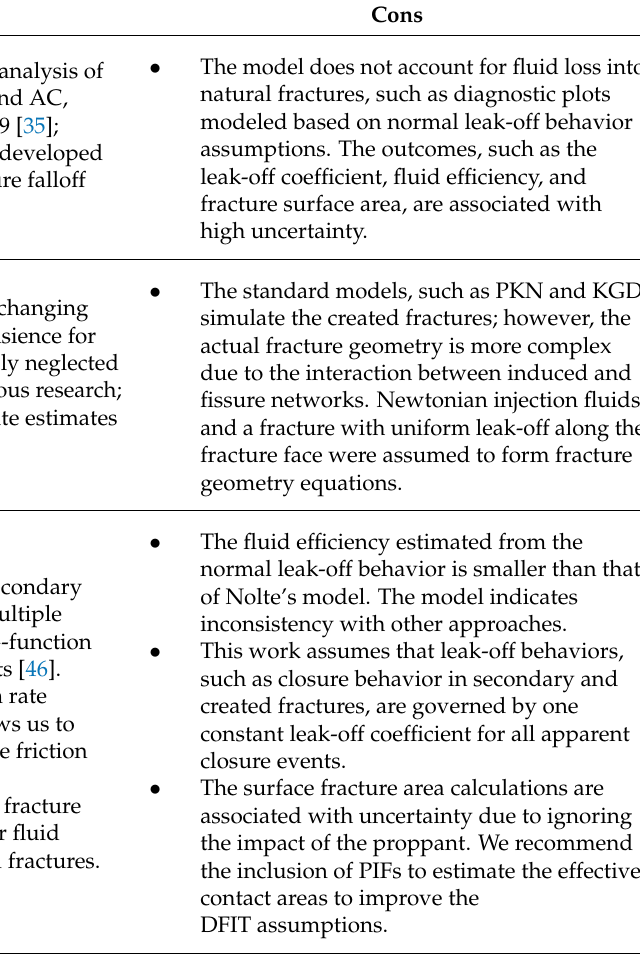
Table 7. Recently published DFIT models under the conditions of abnormal leak-off behaviors. Model Pros